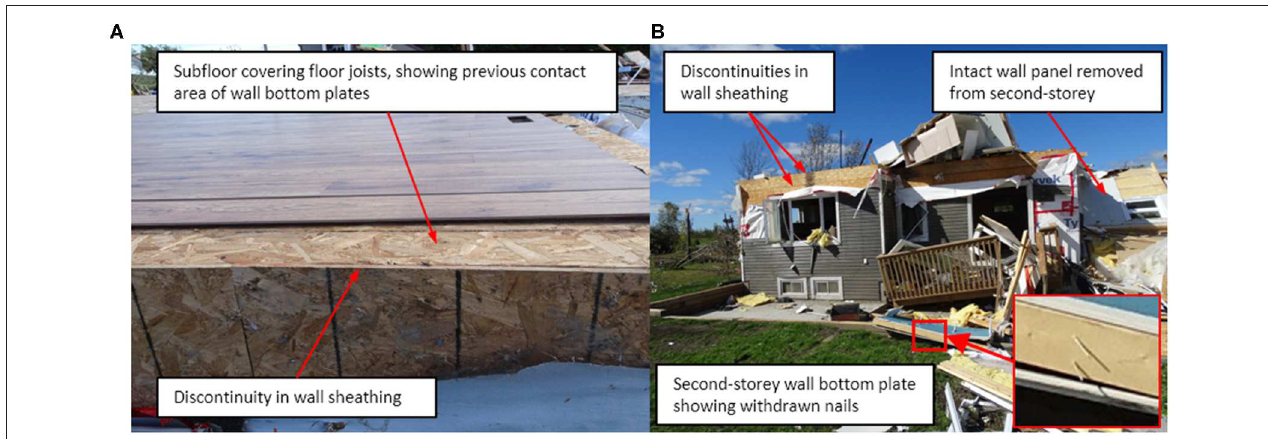
FIGURE 7 | Examples of wall failure showing (A) remaining first-story floor structure, including interior flooring panels, with exposed subfloor around the perimeter where wall bottom plates have been removed, and (B) loss of second-story walls showing bottom plate nail withdrawal. Taken following the EF3 tornado that took place in Dunrobin, ON in September